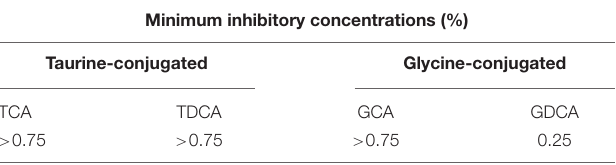
TABLE 2 | Minimum inhibitory concentrations of bile salts against strain JCM 5343 T . Minimum inhibitory concentrations (%) Taurine-conjugated